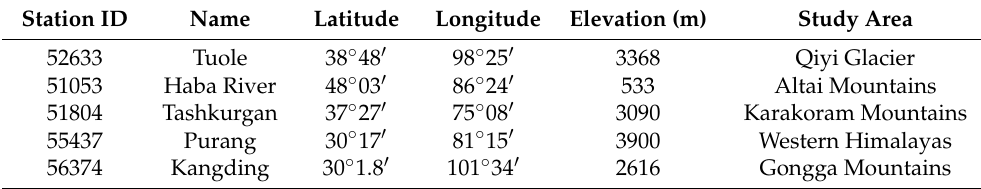
Table 2. Information on the nearest meteorological stations to the analyzed glacier